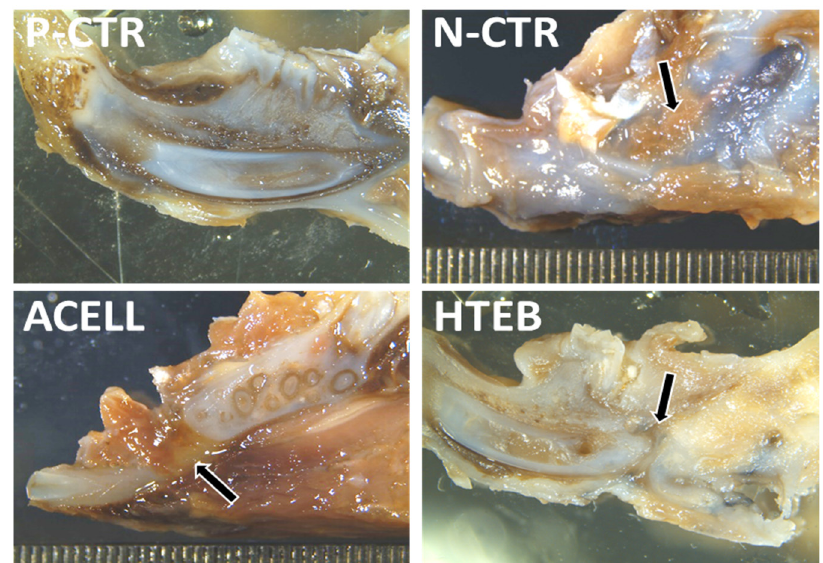
Figure 3. Gross macroscopic view of the right mandible of each group of animals included in the study. Tissues were fixed, decalcified, and sectioned in the sagittal plane to show the area of the defect. P-CTR: native normal animals, used as positive controls; N-CTR: animals subjected to surgical removal of a fragment of the right mandible, used as negative controls; ACELL: animals subjected to surgical removal of a fragment of the right mandible and implant of a nanostructured fibrin–agarose biomaterial; HTEB: animals subjected to surgical removal of a fragment of the right mandible and implant of a nanostructured human tissue-engineered bone substitute.